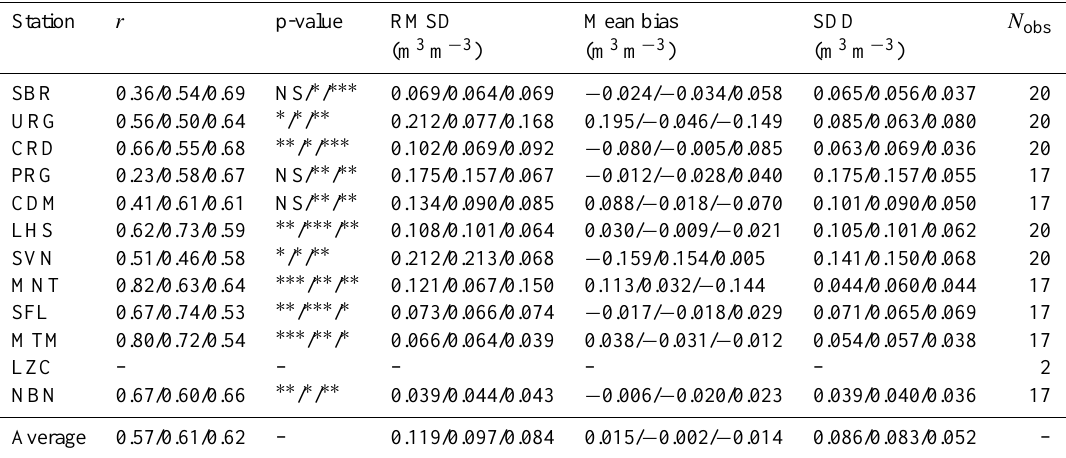
Table 1. Comparison of SSM time series for (from left to right) SMOSMANIA vs. CAROLS, CAROLS vs. ISBA-A-gs, and ISBA-A-gs vs. SMOSMANIA. The Pearson correlation coefficient ( r ), p-value, RMSD, bias (SMOSMANIA minus CAROLS, CAROLS minus ISBA- A-gs, ISBA-A-gs minus SMOSMANIA, respectively) and the standard deviation of differences (SDD) are given for the pooled 2009 and 2010 CAROLS